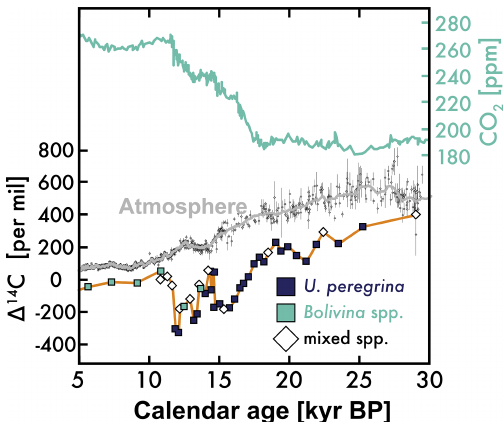
Figure 1. Atmospheric carbon dioxide (CO 2 ) concentrations (top; blue) (Ahn and Brook, 2014; MacFarling Meure et al., 2006; Mar- cott and Shakun, 2017; Monnin, 2001), atmospheric (cid:49) 14 C (mid- dle: blank symbols are observations, gray line is smoothed average) (Reimer et al., 2013), and benthic foraminifera (cid:49) 14 C from sediment bathed in California Undercurrent water (orange; see Table 1 and maps in Fig. 2) (Lindsay et al., 2015; Marchitto et al., 2007). These observations are shown from 30 to 5kyr BP (BP: before